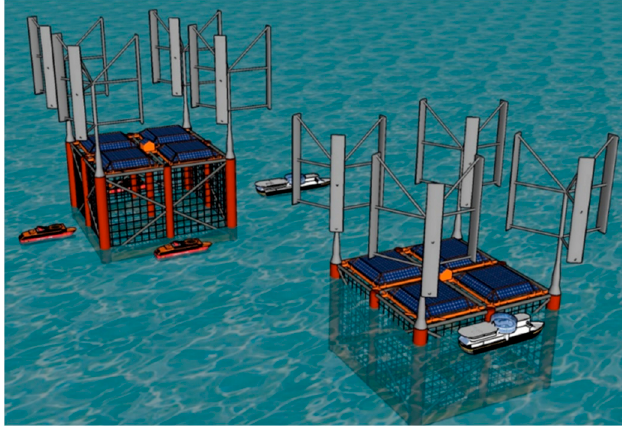
Figure 4. Transit and operation of the WSA.